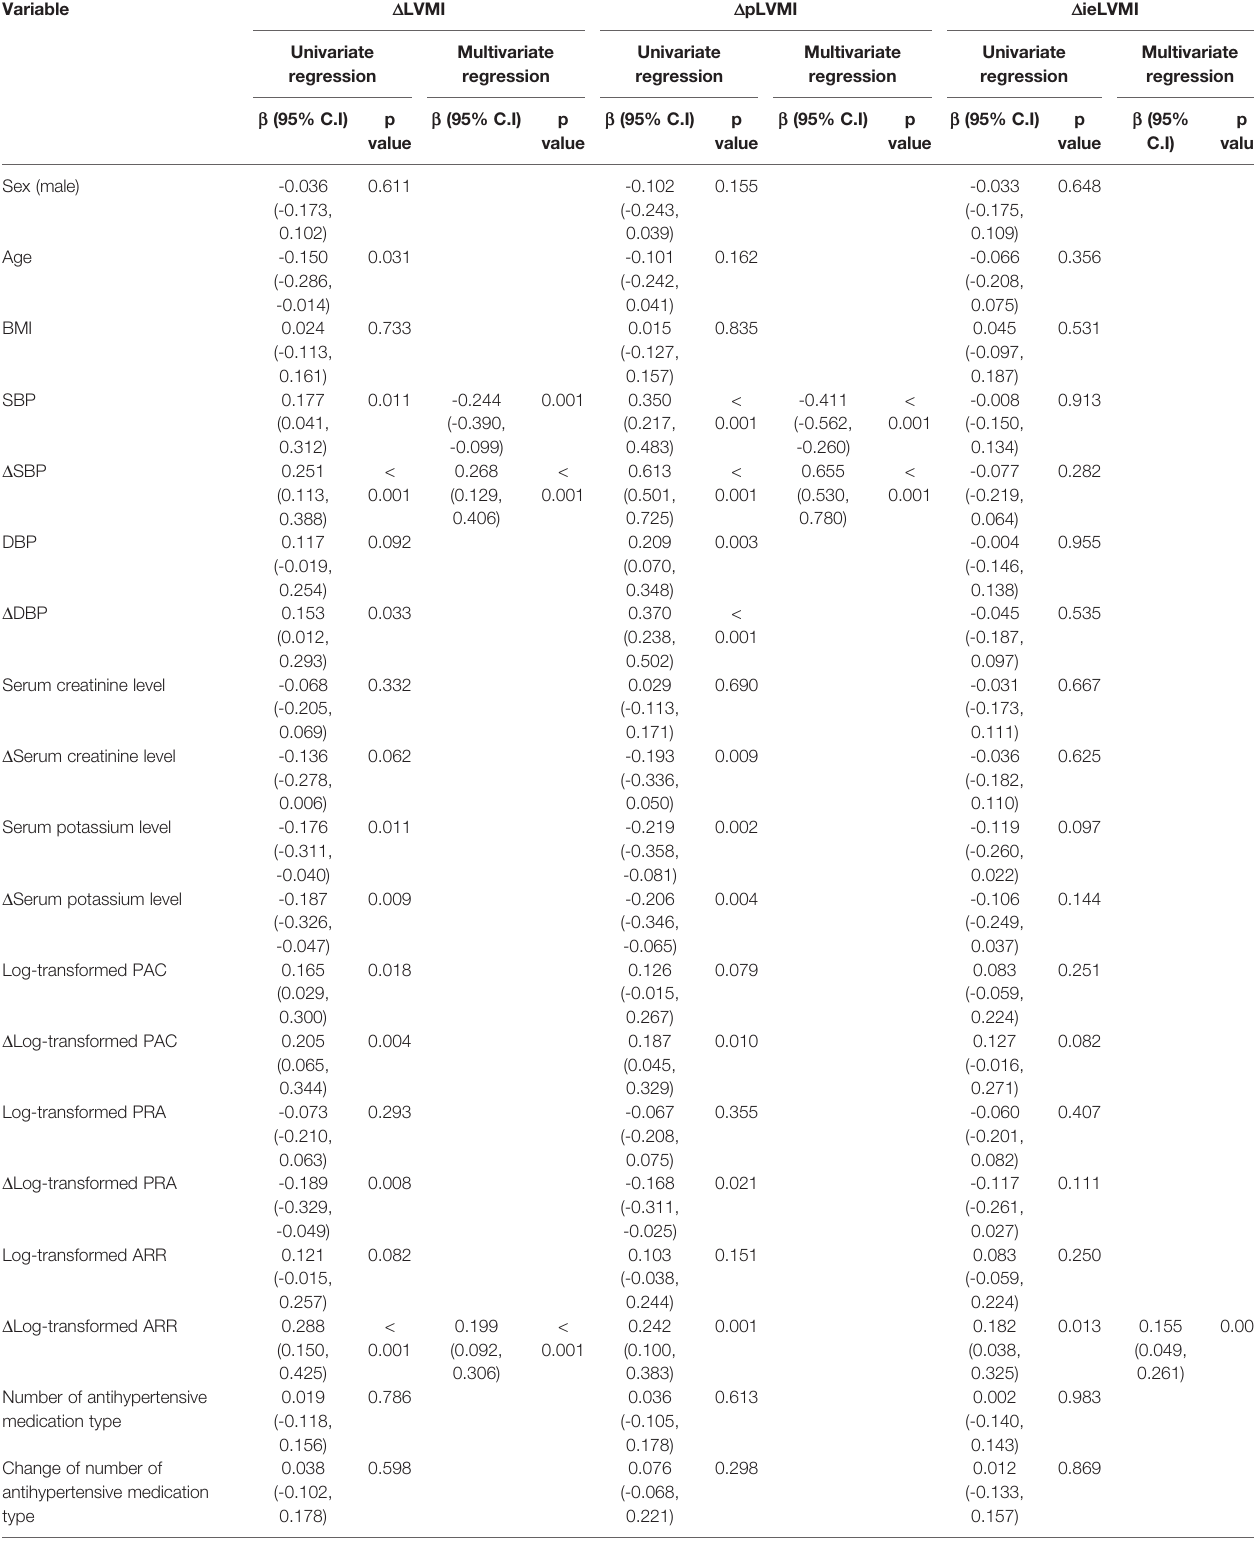
TABLE 5 | Correlation study between D LVMI, D pLVMI, D ieLVMI and clinical parameters